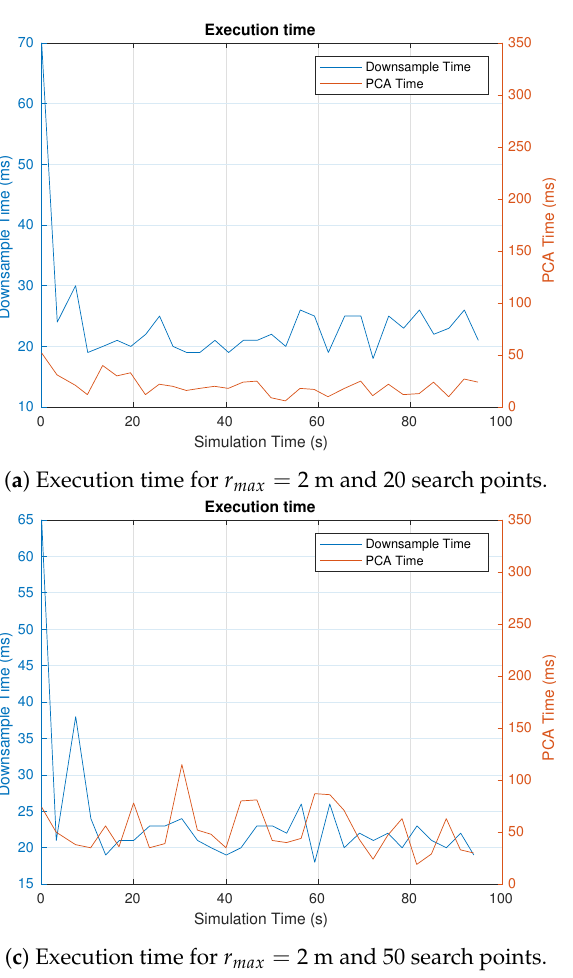
Figure 9. Comparison between downsampling and PCA execution time for the second